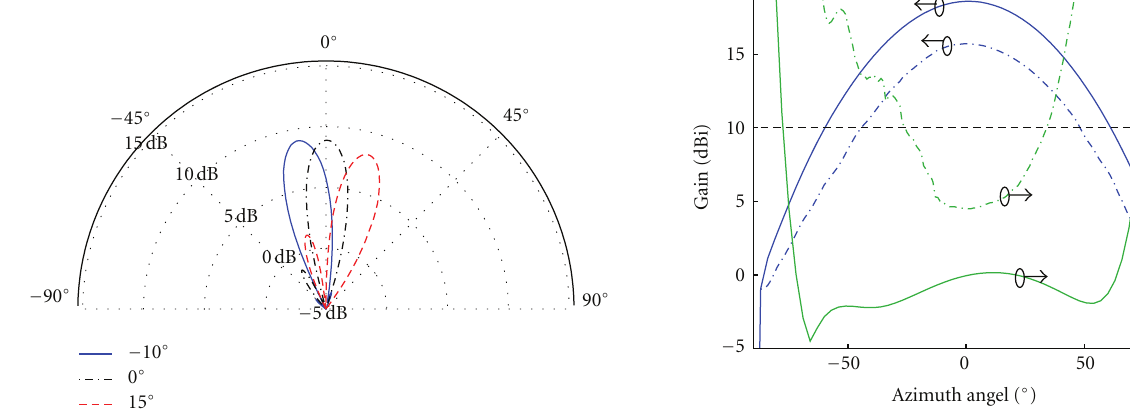
Figure 8: Simulated (full line) and measured (dashed-dotted line) total gain and axial ratio for the active receive